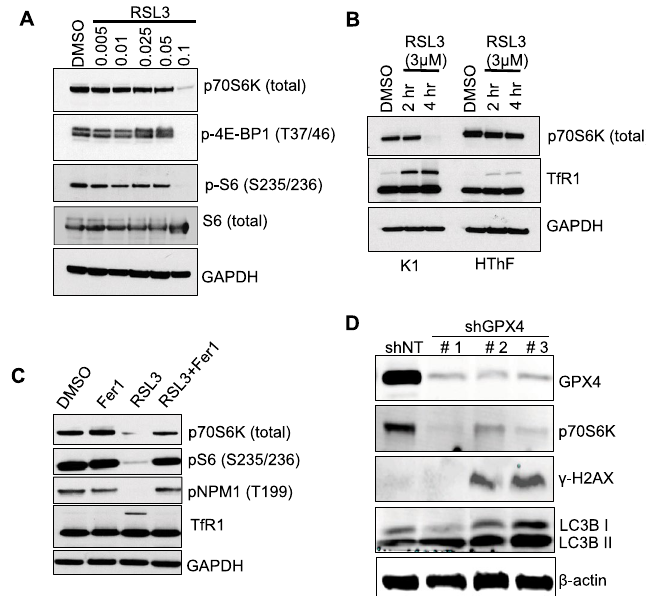
and p-S6 in K1 cells treated with RSL3 or DMSO control for 6 h. ( B ) Western blot showing p70S6K and TfR1 expression in K1 cells or HThF cells treated with RSL3 (3 μM) or DMSO control for 2 and 4 h. ( C )